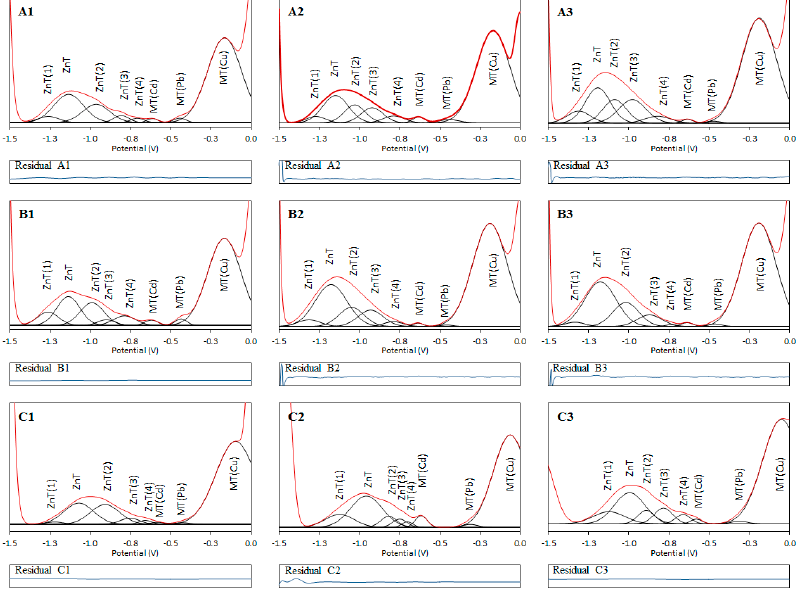
Figure 4. Resolved voltammograms of rMT2 after application of curve fitting method. ( A1 – A3 ) Accumulation times: 120, 240, and 360 s; ( B1 – B3 ) concentration of NaCl: 0.1, 0.3, and 0.5 M; ( C1 – C3 ) pH: 6.5, 7.0, and 7.5. Individual voltammetric signals of metal–MT complexes (black lines), measured non-resolved voltammetric signals (red line), residuals (blue